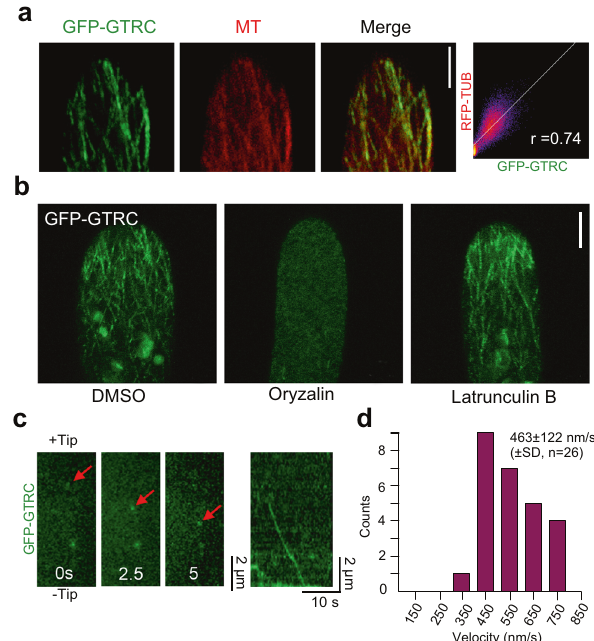
Fig. 4 The localization and movement of GTRC proteins. a Localization of GTRC on the microtubules (MT) in the tip cells of P. patens protonemata. RFP-TUB was co-expressed with GFP-GTRC in the protonemata, and fl uorescence signals were collected by confocal microscopy. The scatterplots show the Pearson ’ s correlation coef fi cient ( r ) between these two fl uorescent signals. Scale bar, 5 μ m. b Localization of GTRC was dependent on tubulin but not actin. Images were taken after 10 min of oryzalin or latrunculin B treatments, and oryzalin but not latrunculin B treatment disrupted the regular signal patterns of GTRC. Scale bar, 5 μ m. More than 10 cells were studied for each treatment, and the results were similar. Oryzalin and latrunculin B disrupt the microtubules and actin fi laments, respectively, as shown in Supplementary Fig. 7. c GTRC moves along MT in the minus-end direction. Left, processive movement of GTRC recorded by time-lapse photography using spinning disk confocal microscopy at 250 ms intervals. Red arrows mark the GFP-GTRC proteins moving along MT. Right, kymographs for the movement of GFP-GTRC. d Velocity of moving GFP-GTRC signals. The mean value is shown with standard deviation and examined sample size. Source data are provided as a Source Data fi